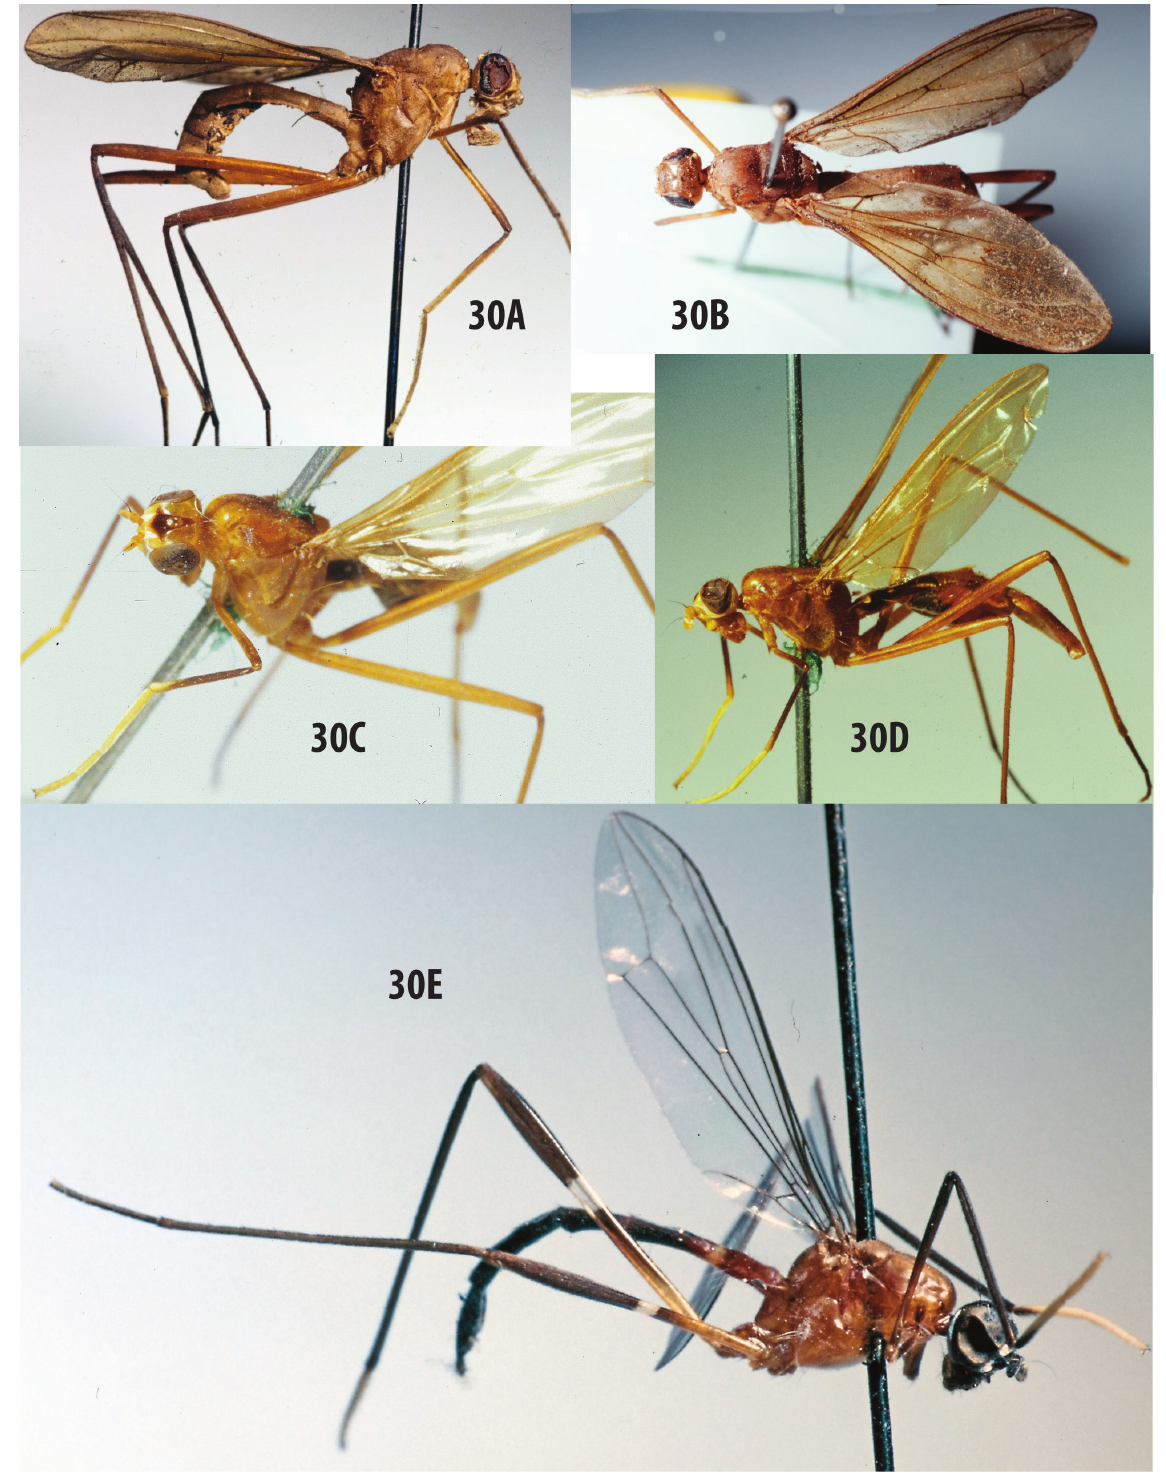
Fig. 30. Species of the Mesoconius nono group known only from original type specimens. A–B . Mesoconius hoffmannsi (Enderlein, 1922), holotype (Peru), ♂, MNBG. C–D . Mesoconius ottoi nom. nov. (replacement name for Tanypoda garleppi Enderlein, 1922), lectotype (Bolivia), ♀, MNBG. E . Mesoconius scurrus (Hennig, 1935), holotype (Bolivia), ♂,